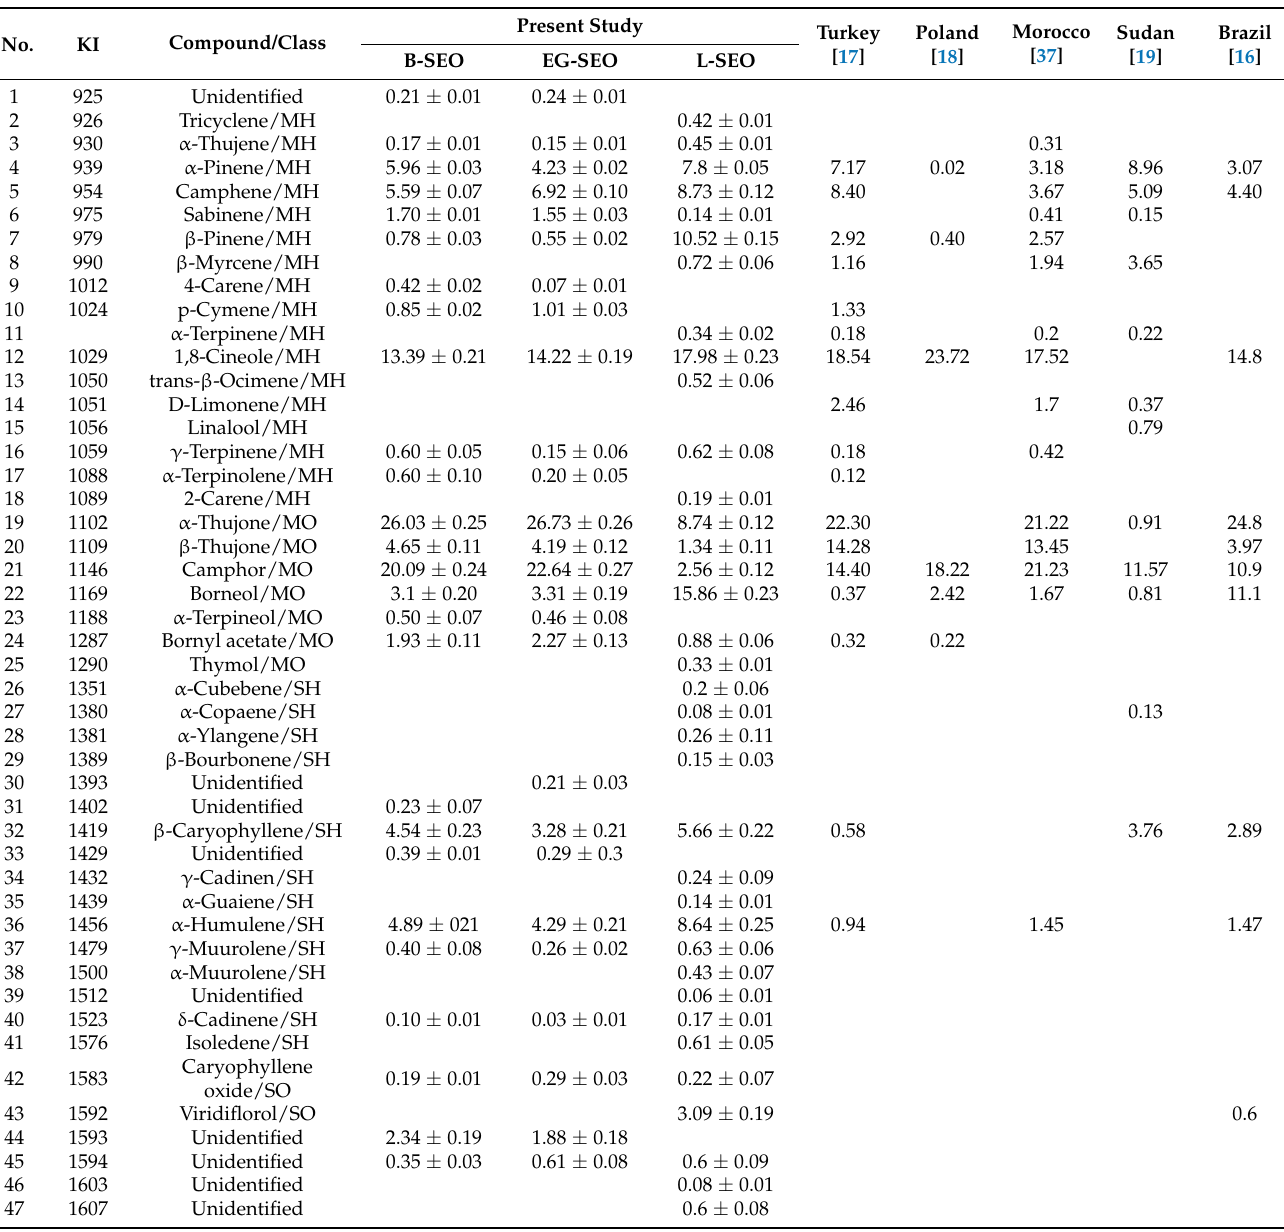
Table 1. Salvia officinalis L. essential oil chemical composition (% TIC) determined by GC-MS